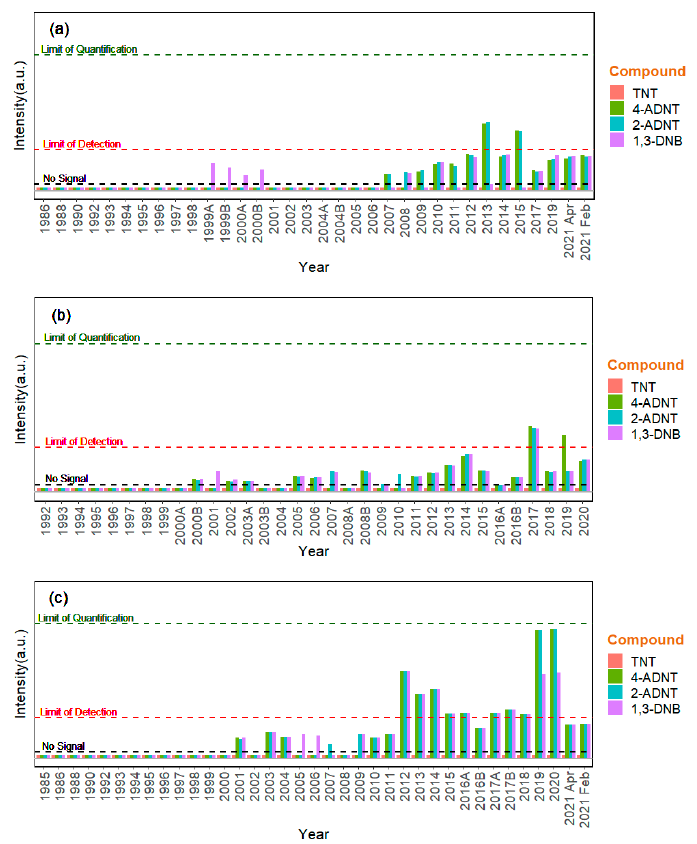
Figure 2. Energetic compounds in blue mussel samples from ( a ) Königshafen (Sylt), ( b ) Darßer Ort, and ( c ) Eckwarderhörne. A and B denote samples received from the same year treated in two di ff er- ent aliquots, which were both analyzed for quality assurance.